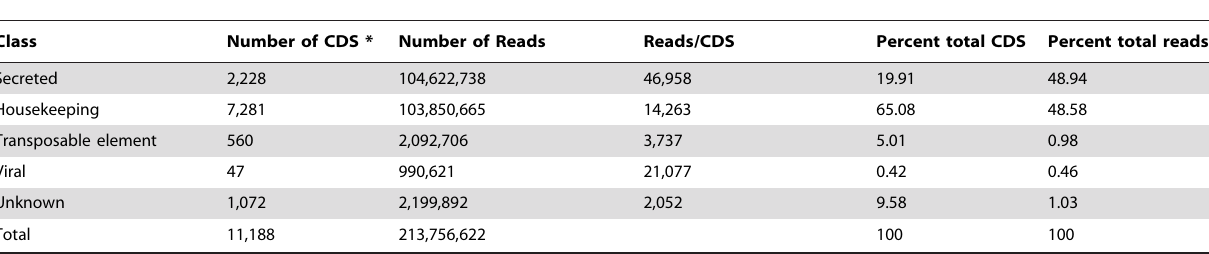
Table 4. Classification and metrics of the assembled sialome of Triatoma infestans